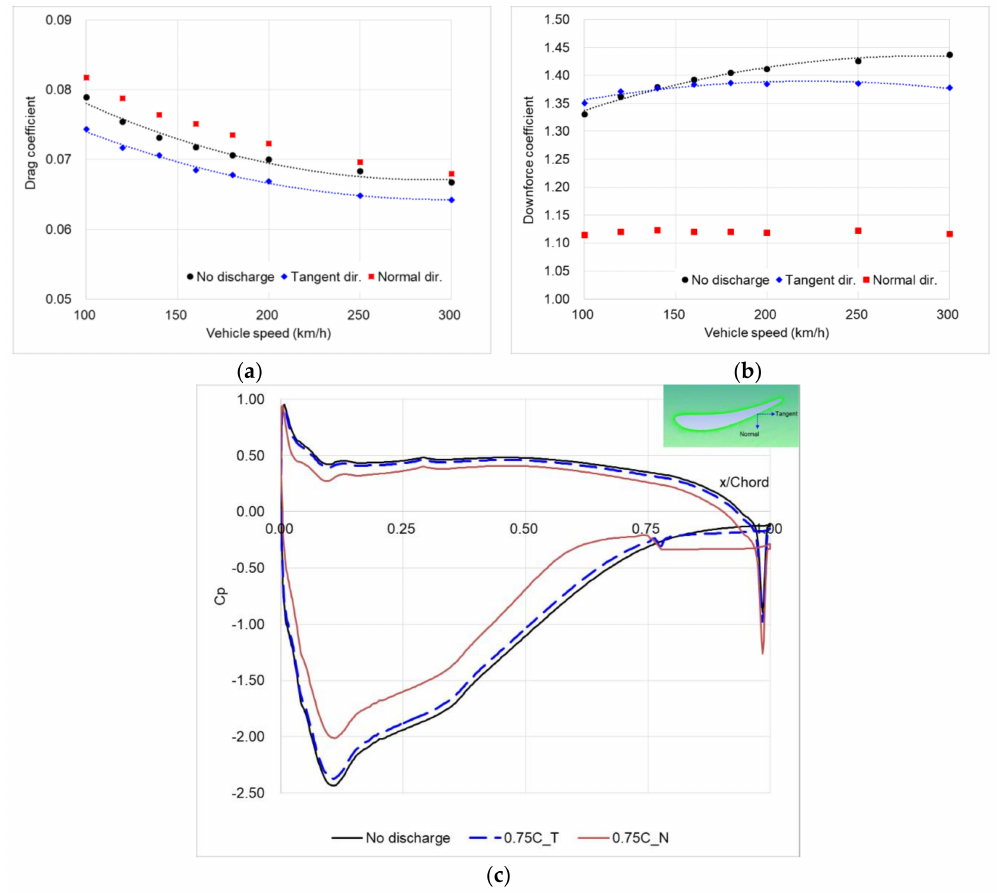
Figure 9. E ff ect of discharge direction when the discharge position is 0.75C and Vb / U = 0.4. Comparison of ( a ) drag coe ffi cient; ( b ) downforce; and ( c ) surface pressure distributions for flow discharge in the normal and tangential directions.